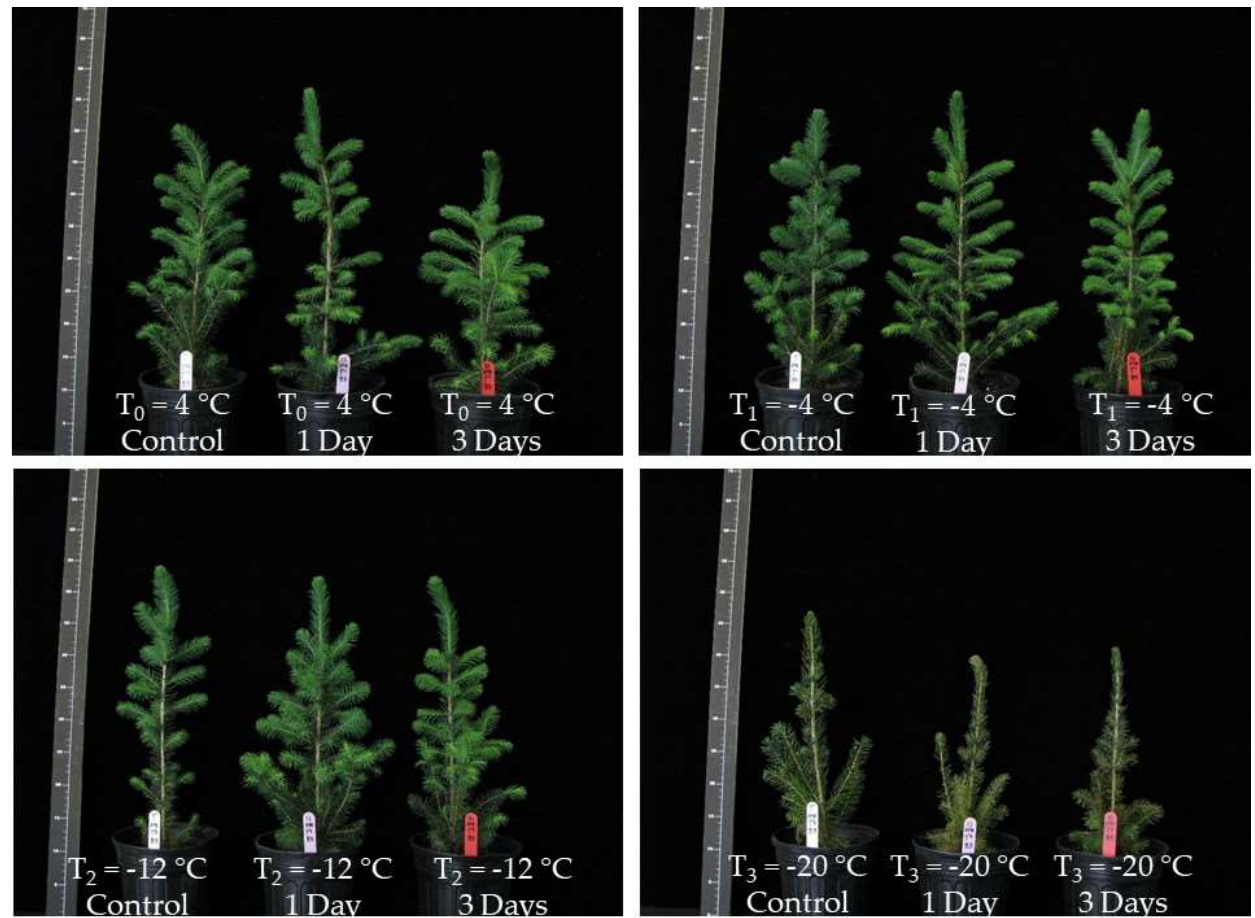
Figure 8. Normal bud break of the apical buds and lateral branches of white spruce seedlings (2 + 0) at the end of winter (mid-March) in response to their exposure to the three warming treatments (control at 4 ◦ C in the dark conditions, 1 day at 10 ◦ C, and 3 days at 10 ◦ C under the natural photoperiod of the season) and followed by artificial freezing temperatures ( − 4 ◦ C and − 12 ◦ C). Conversely, seedlings subjected to the − 20 ◦ C freezing temperature and the same warming treatments showed no bud burst.